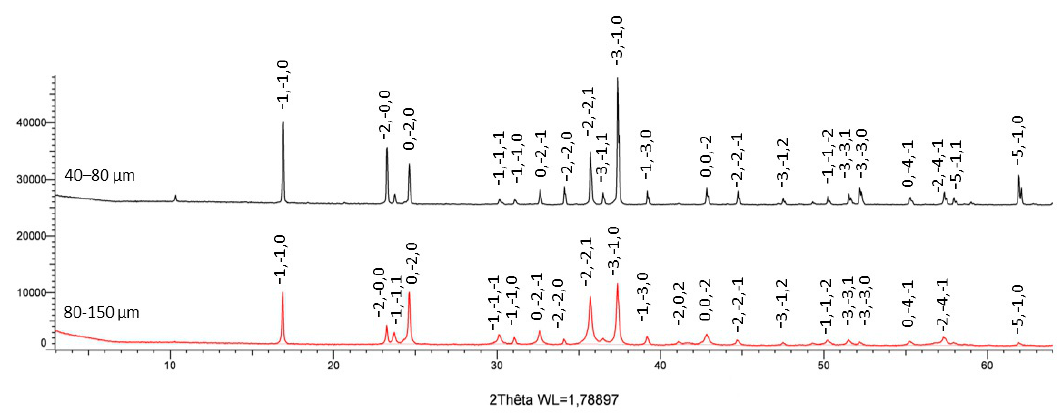
Figure 9. The XRD patterns of the spodumene samples. Table 1. Relative intensities of the main planes of the fine and coarse fractions of spodumene. Crystalline